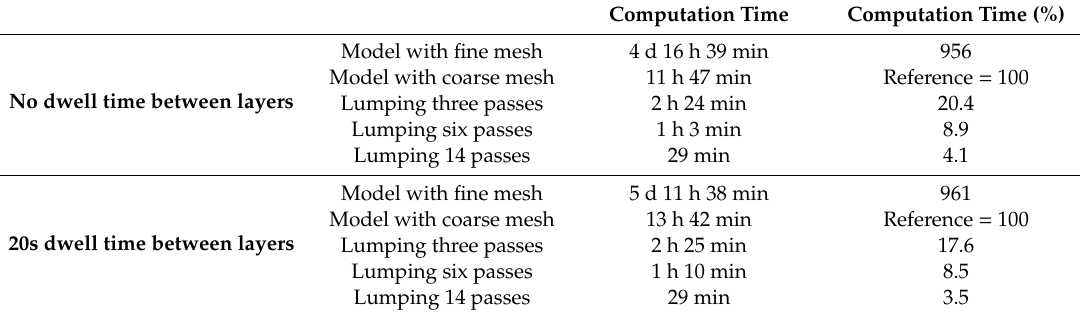
Table 8. Computation time for the simulation